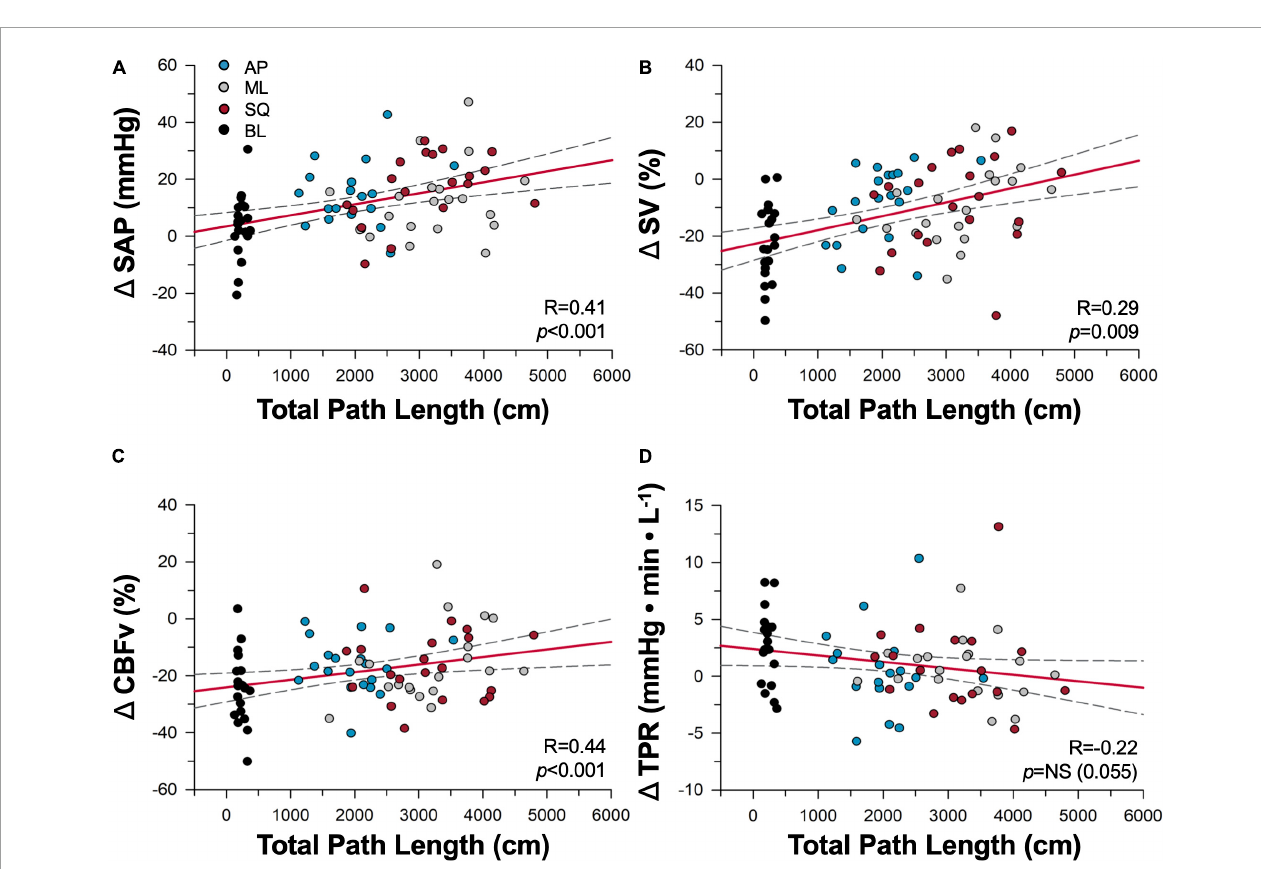
FIGURE4 Dose-dependence of cardiovascular responses to sway. Correlations between total path length of sway and cardiovascular responses of (A) systolic arterial pressure (SAP), (B) stroke volume (SV), (C) cerebral blood flow (CBFv), and (D) total peripheral resistance (TPR) are shown during baseline (black), anterior-posterior (blue), mediolateral (grey), and square (red) conditions. Regression lines are shown in red, and 95% confidence intervals shown with black dotted lines. NS, not